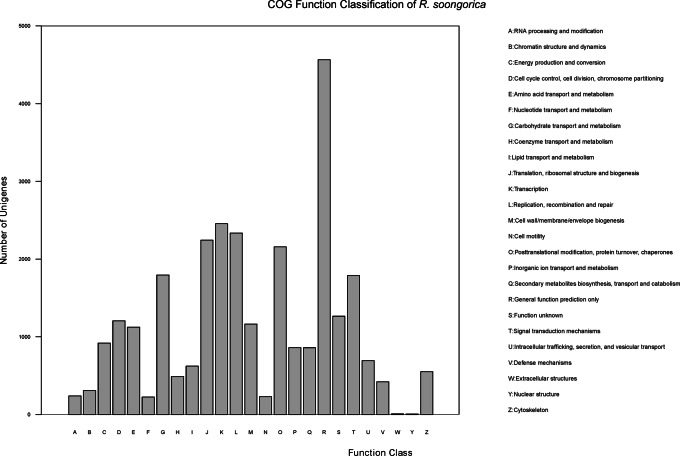
COG function classification.Total 14,987 unigenes were assigned to 25 COG classifications. The largest cluster was for general function prediction only (4,564, 15.99%), followed by transcription (2,455, 8.60%), replication, recombination and repair (2,335, 8.18%), translation, ribosomal structure and biogenesis (2,243, 7.86%), posttranslational modification, protein turnover, and chaperones (2,157, 7.56%), carbohydrate transport and metabolism (1,795, 6.29%) and signal transduction mechanisms (1,788, 6.27%).